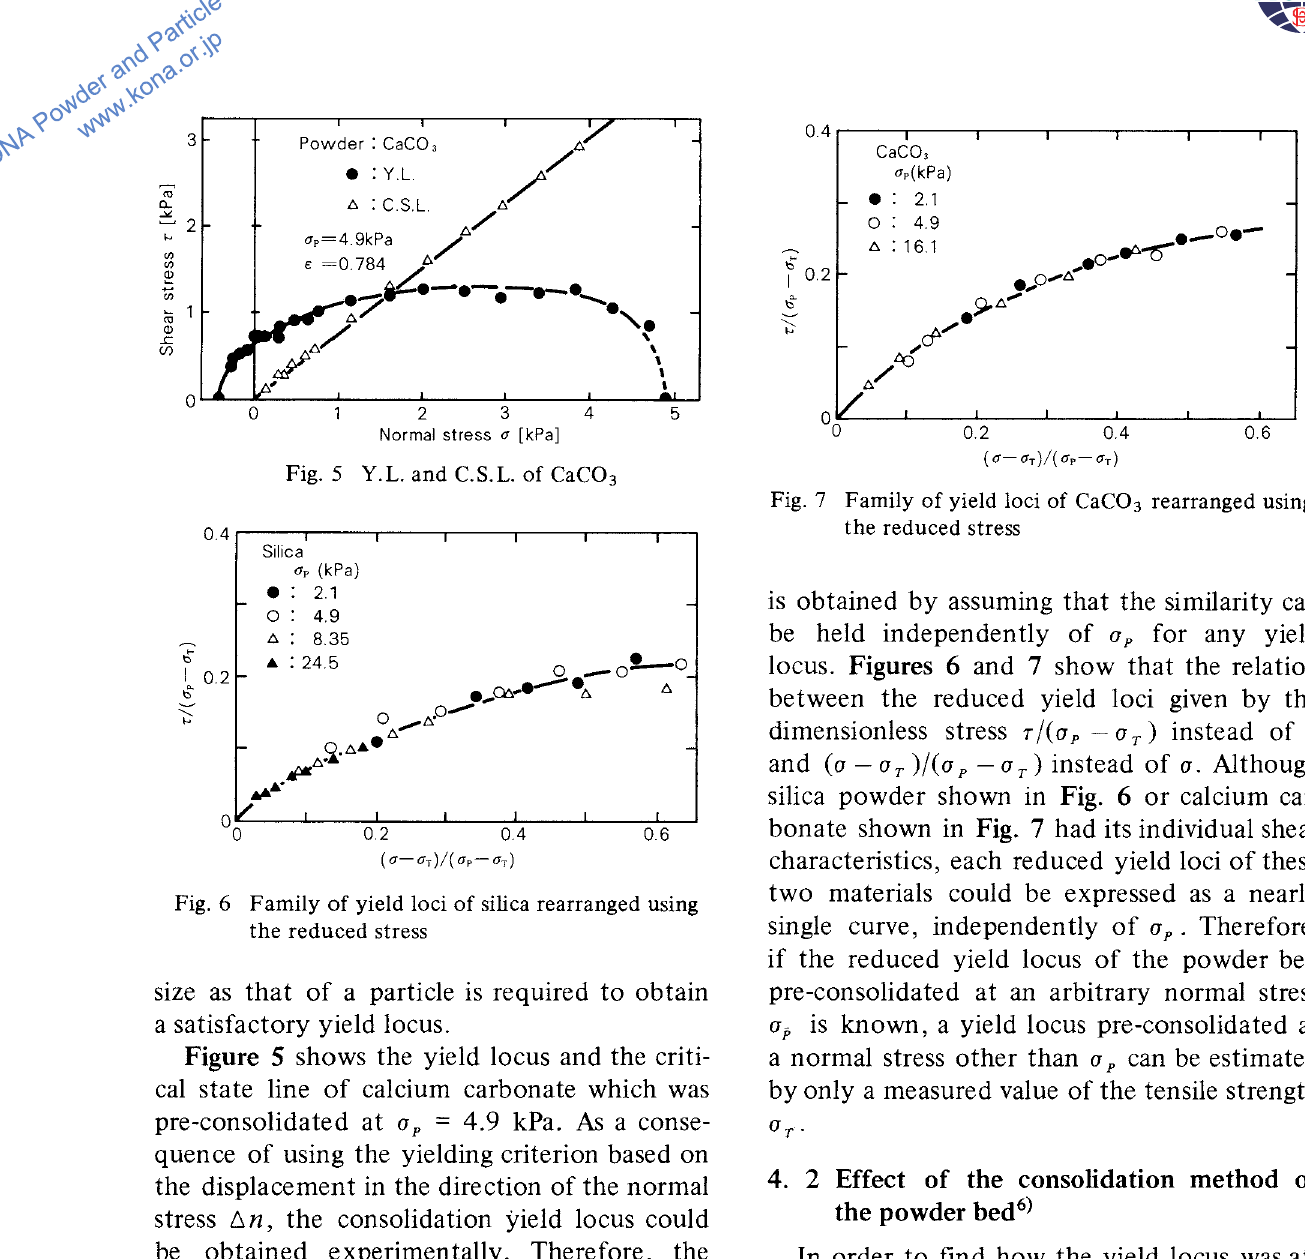
Fig. 7 Family of yield loci of CaC0 3 rearranged using the reduced